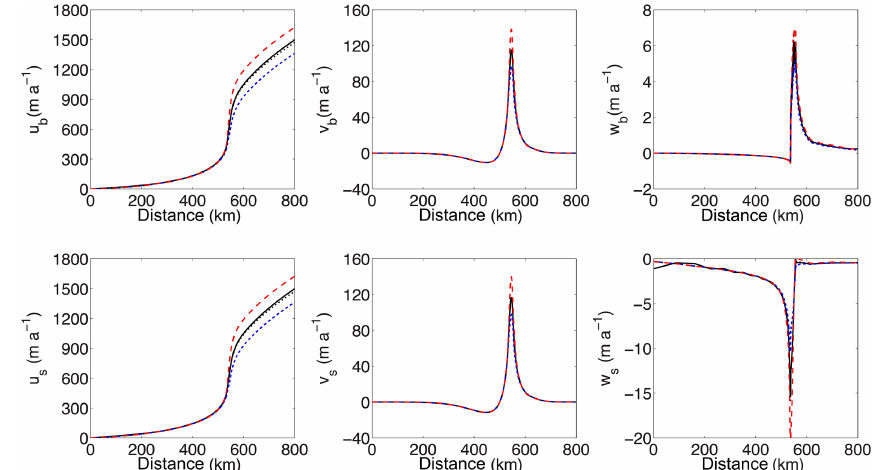
Figure 2. Comparisons of across-flow-averaged velocities for lower ( u b , v b , w b ) and upper ( u s , v s and w s ) surfaces along the x direction for FELIX-S (black solid line), Elmer/Ice FF (red dashed line), DI (black dotted line), and LG (blue dotted line) cases for the diagnostic experiment P75D. Where the black dotted line is not clearly visible, Elmer/Ice and FELIX-S solutions are